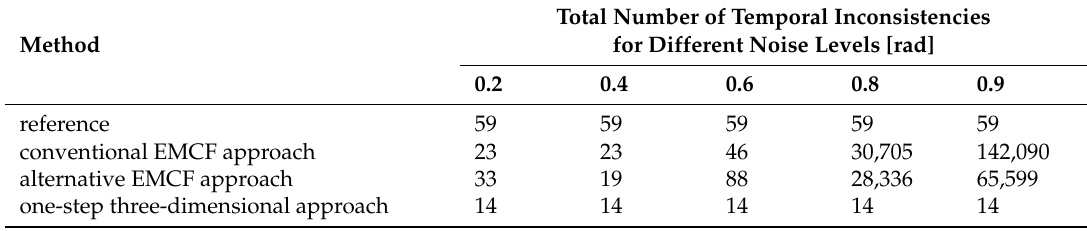
Table 1. Total number of temporal inconsistencies for different noise levels. In addition to the reference, the number is listed for different phase unwrapping methods.